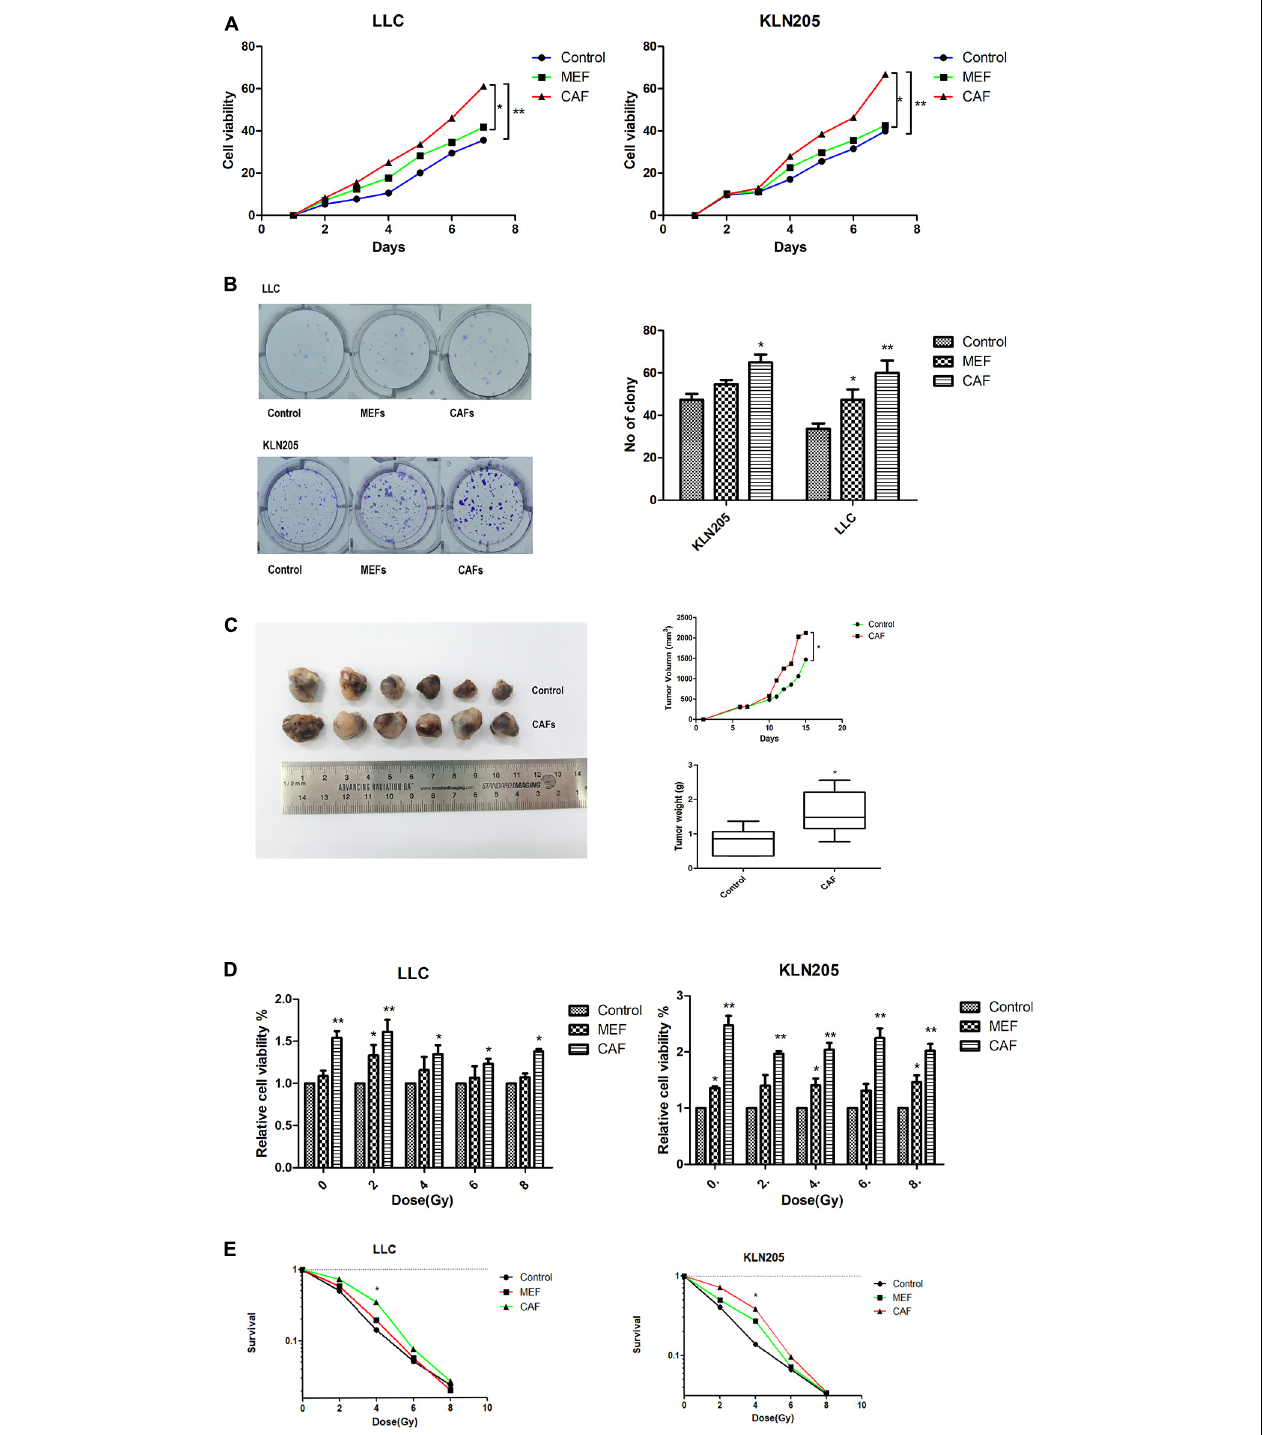
FIGURE 2 | The impact of CAFs on lung cancer cell proliferation and radiosensitivity. (A,B) The impact of CAFs on cell viability and proliferation of lung cancer cells were examined by CCK-8 assay and clonogenic survival assay. (C) Tumor volume and weight of xenografts were measured with calipers and electronic balance. The mean tumor volume in CAF and Control groups were 2122.52 ± 365.95 mm 3 and 1467.10 ± 436.41 mm 3 , respectively. The mean tumor weight in CAF and Control groups were 1.61 ± 0.84 g and 0.79 ± 0.44 g, respectively. (D,E) The impact of CAFs on cell viability and proliferation of lung cancer cells after radiotherapy for 0, 2, 4, 6, 8 Gy were examined by CCK-8 assay and clonogenic survival assay. Statistical significance is shown (* p < 0.05; ** p < 0.01). MEF, mouse fetal fibroblast cell; CAF, cancer associated fibroblast; LLC, Lewis lung cancer cell; KLN205, mouse squamous cell lung cancer cell.